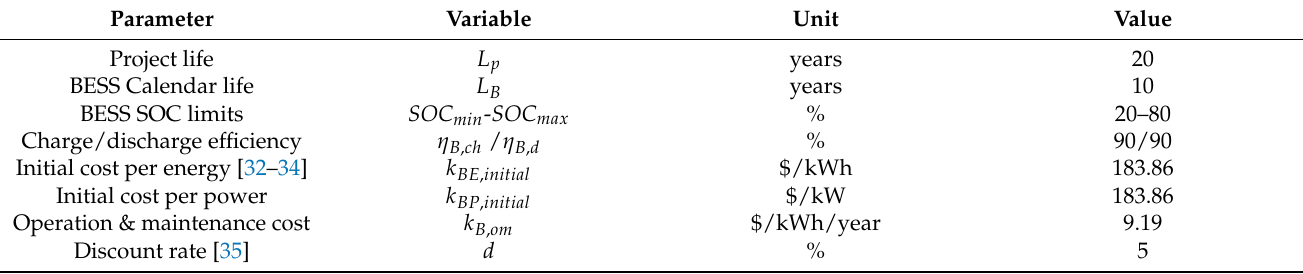
Table 1. Case study